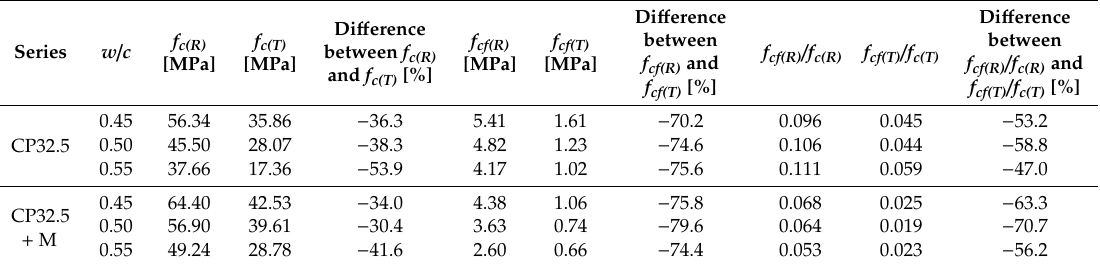
Table 2. Values of coefficients of variation for the results of mechanical parameters.